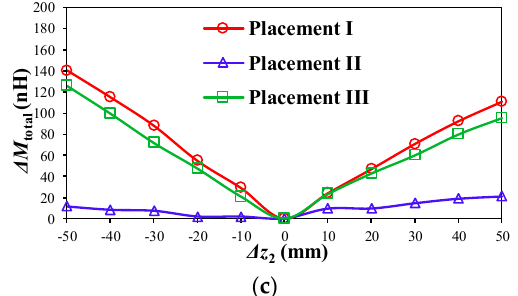
Figure 7. Total change of effective mutual inductances Δ M total when the secondary coil moves along: ( a ) x axis; ( b ) y axis; and ( c ) z axis.